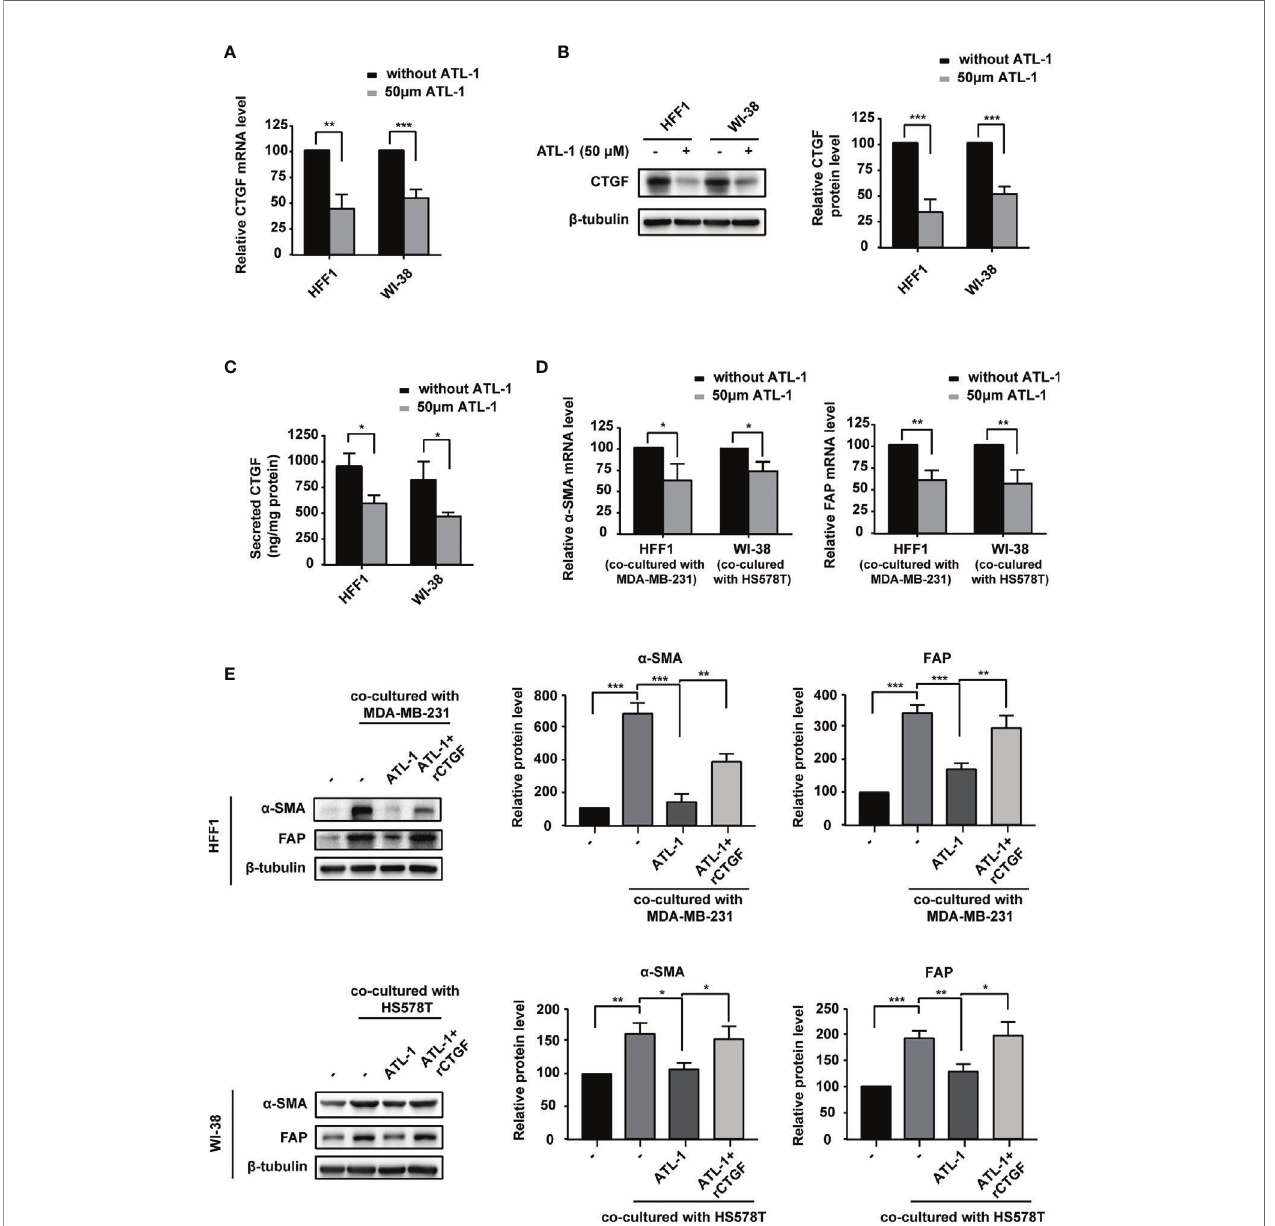
FIGURE 4 | ATL-1 downregulates fi broblast expression of CTGF and inhibits the ability of breast cancer cells to transform fi broblasts into CAF-like cells. (A) qPCR illustrated downregulation of CTGF mRNA in HFF1 and WI-38 cells after treatment with 50 m M ATL-1 for 24 hrs. Western blotting (B) and ELISA (C) illustrated downregulation of the CTGF protein and secreted protein levels of HFF1 and WI-38 cells after treatment with 50 m M ATL-1 for 24 hrs. qRT-PCR (D) demonstrated that treatment with 50 m M ATL-1 in the co-culture system for 48 hrs downregulated the mRNA levels of CAF markers compared with no ATL-1 treatment. Western blotting (E) demonstrated that co-culture with cancer cells upregulated the protein levels of the CAF markers FAP and a -SMA in HFF1 and WI-38 cells. Treatment with 50 m M ATL-1 in the co-culture system for 48 hrs downregulated the protein levels of CAF markers compared with no ATL-1 treatment. rCTGF rescued the downregulation. (-) in (E) represent without ATL-1 and rCTGF treatment. (A – E) Three technical replicates were performed for each of the three biological replicates. Mean ± SD, *p < 0.05, **p < 0.01, ***p < 0.001 by Student ’ s t